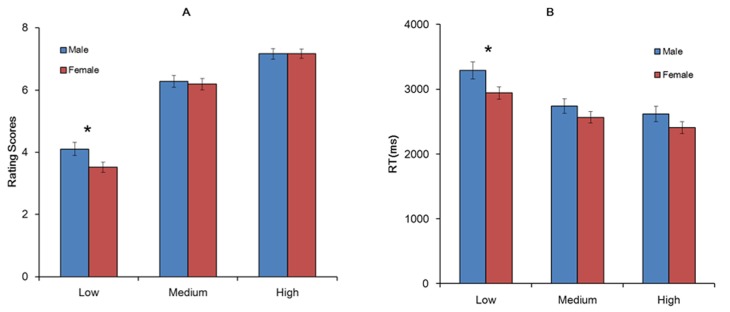
Rating scores (A) and reaction times (B) over types of stimuli (low, medium, and high romance levels).Significance bars and asterisks designate the significance of rating and reaction time for the gender by stimulus type interactions. *, p<0.05.